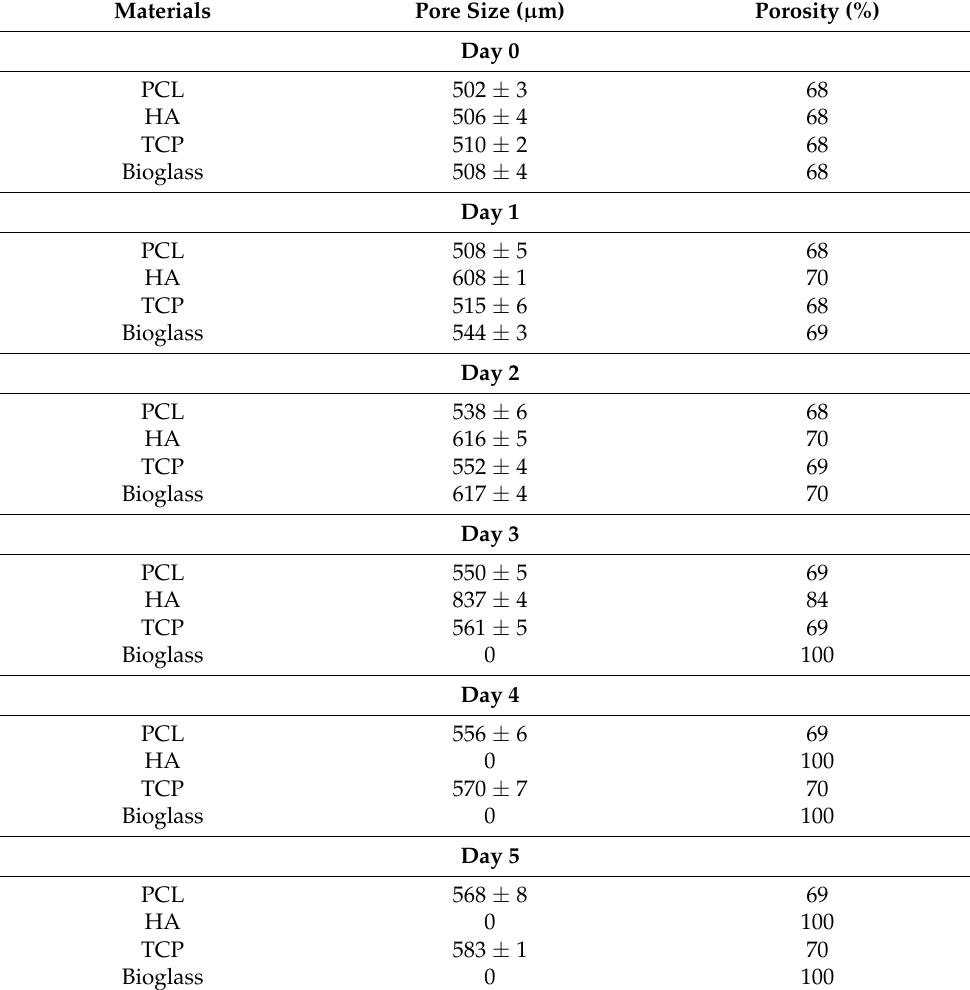
Table 4. Pore size and porosity values of scaffolds (500 µ m pore size) before and after the degradation